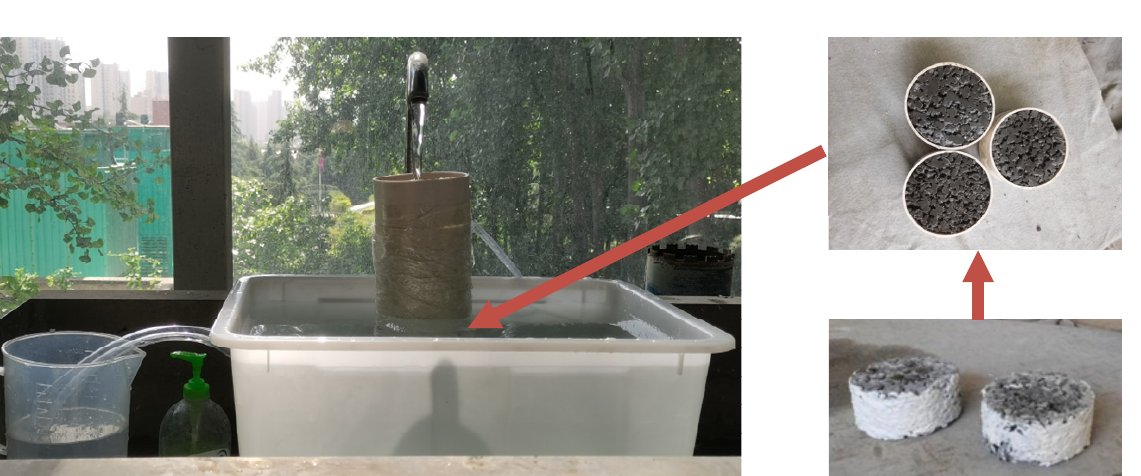
Figure 7. The flexural tensile strength of the specimens with different levels of basalt fiber content.